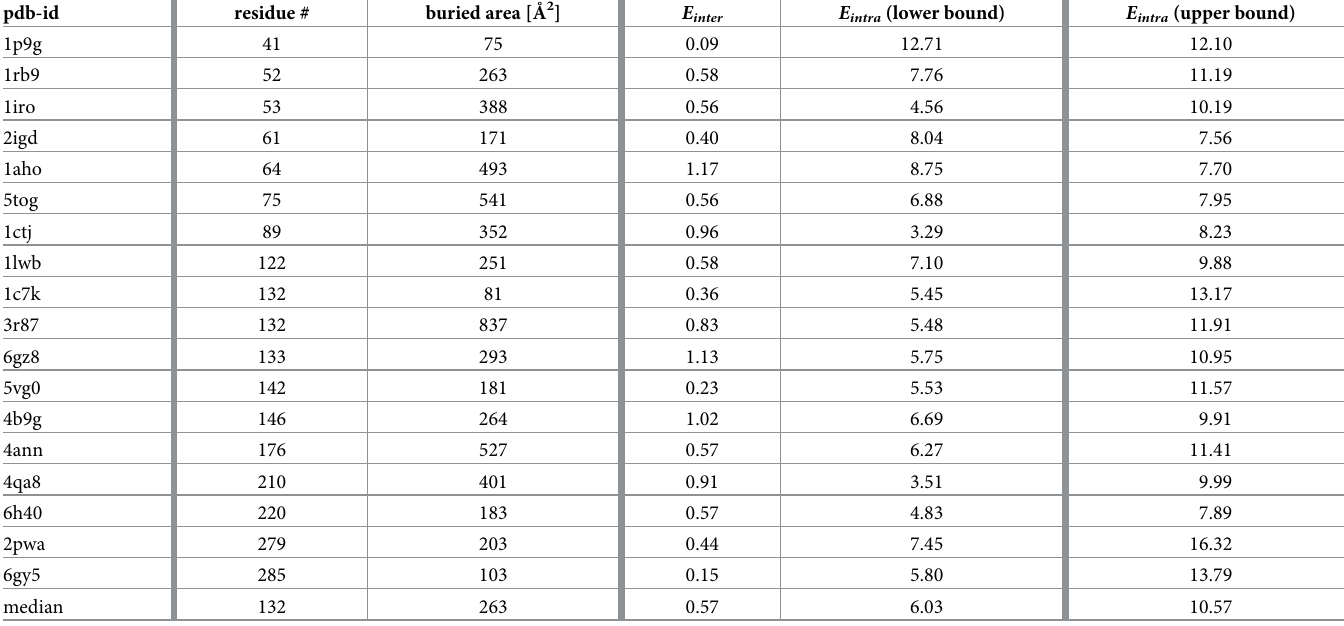
Table 2. The lower and upper bounds of Young’s moduli of the 18 proteins and the Young’s moduli of the interface regions of the corresponding quaternary struc- tures artificially generated based on crystal contacts. pdb-id